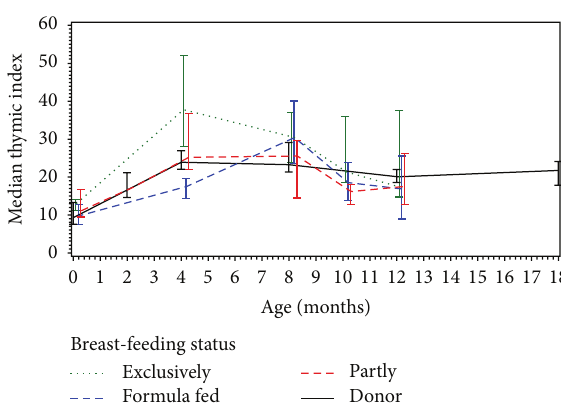
Figure 2: Feeding mode at 4 months of age had a significant impact on the thymic size. Those breastfed at 4 months of age have the largest thymus when compared to the three other feeding groups. However, the HIV-EU infants at 4 months of age have a thymic size the same as the partially breastfed infants. By 8- and 12- month followups the difference in Ti between the feeding groups disappeared. Ti is given as medium and with Q 1 and Q 3